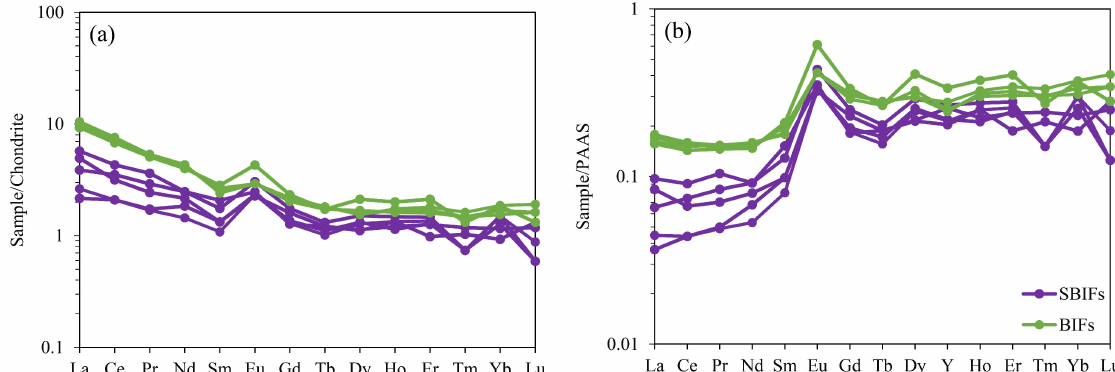
Figure 9. Chondrite—( a ) and ( b ) PAAS-normalized REE-Y of the Anyouzok iron formations (BIFs and SBIFs). Normalization values after